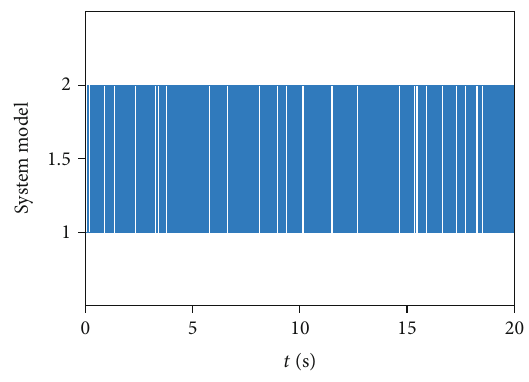
Figure 7: Switching of system